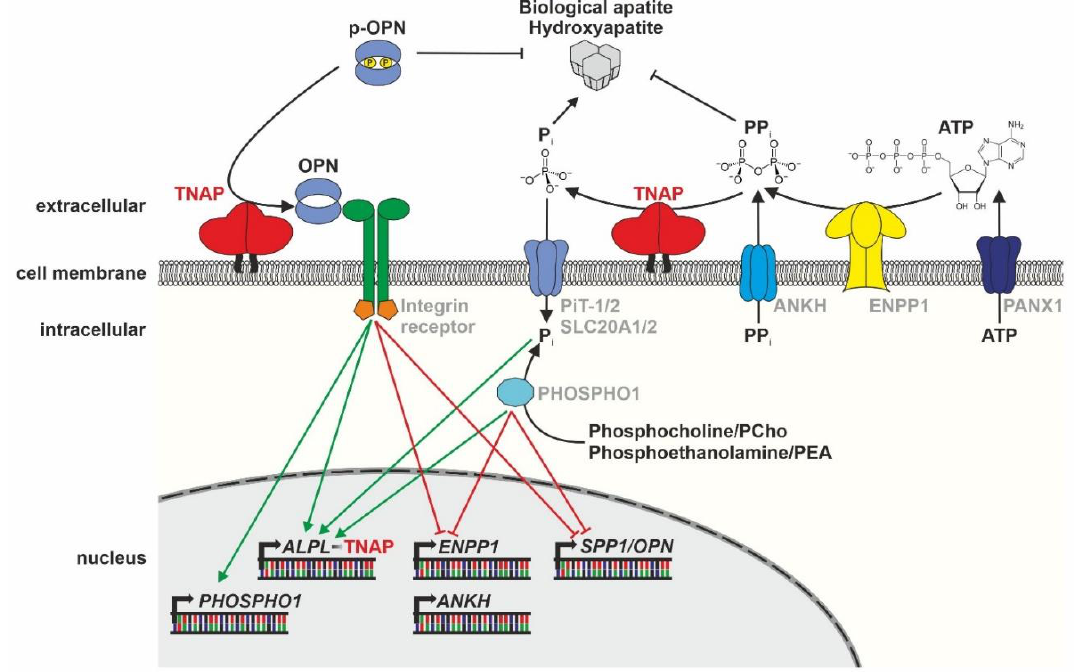
Figure 2. Schematic model of TNAP function within mineralizing cells (Modified according to Yadav et al. 2014 [67]). ATP: adenosine triphosphate, ANKH: progressive ankylosis protein homolog, ENPP1: ectonucleotide pyrophosphatase / phosphodiesterase family member 1, SPP1 / OPN: secreted phosphoprotein 1 / osteopontin, Phospho1: phosphoethanolamine / phosphocholine phosphatase, Pi: Phosphate, PiT-1 / 2: sodium-dependent phosphate transporters 1 and 2, p-OPN: phosphorylated osteopontin, PPi: inorganic pyrophosphate, TNAP: tissue-nonspecific alkaline phosphatase.